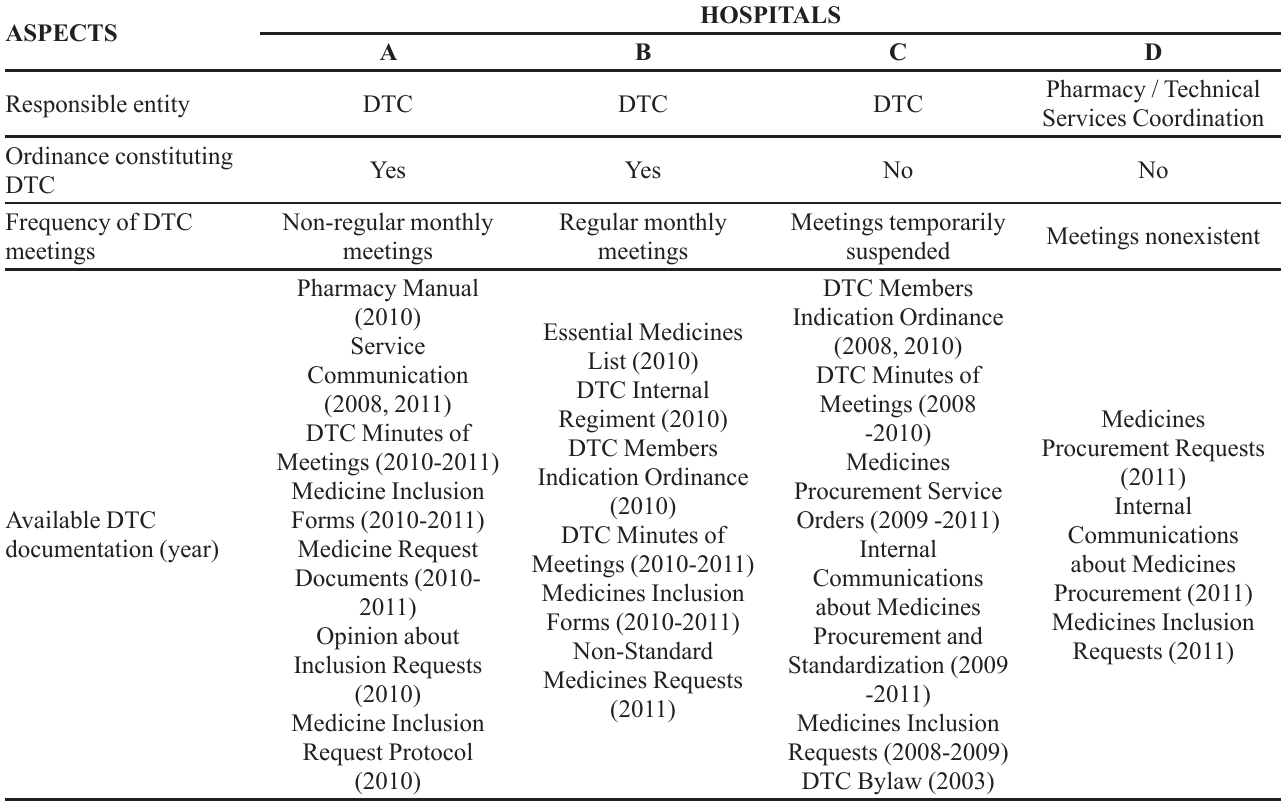
TABLE II - Responsibilities pertaining to medicine selection in university hospitals. State of Rio de Janeiro, 2011